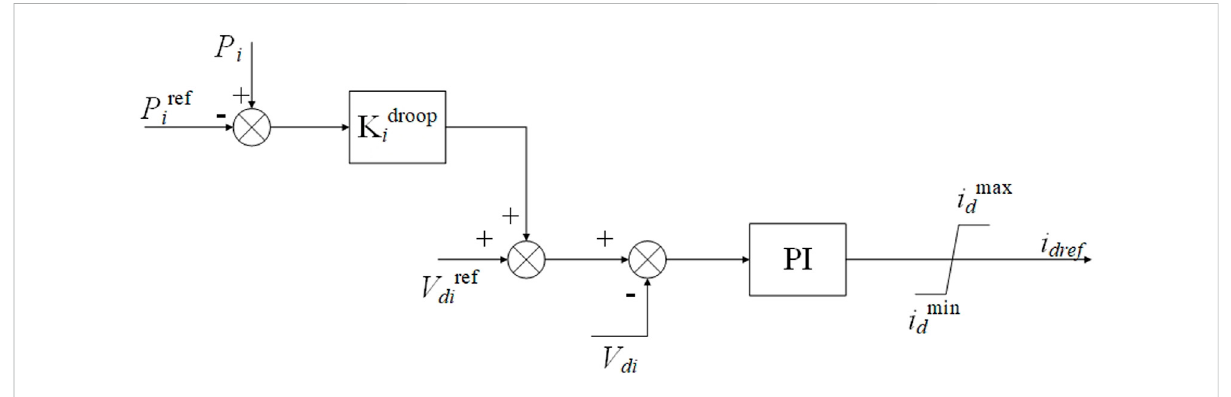
FIGURE 3 The DC voltage-active power droop control of MMC-MTDC